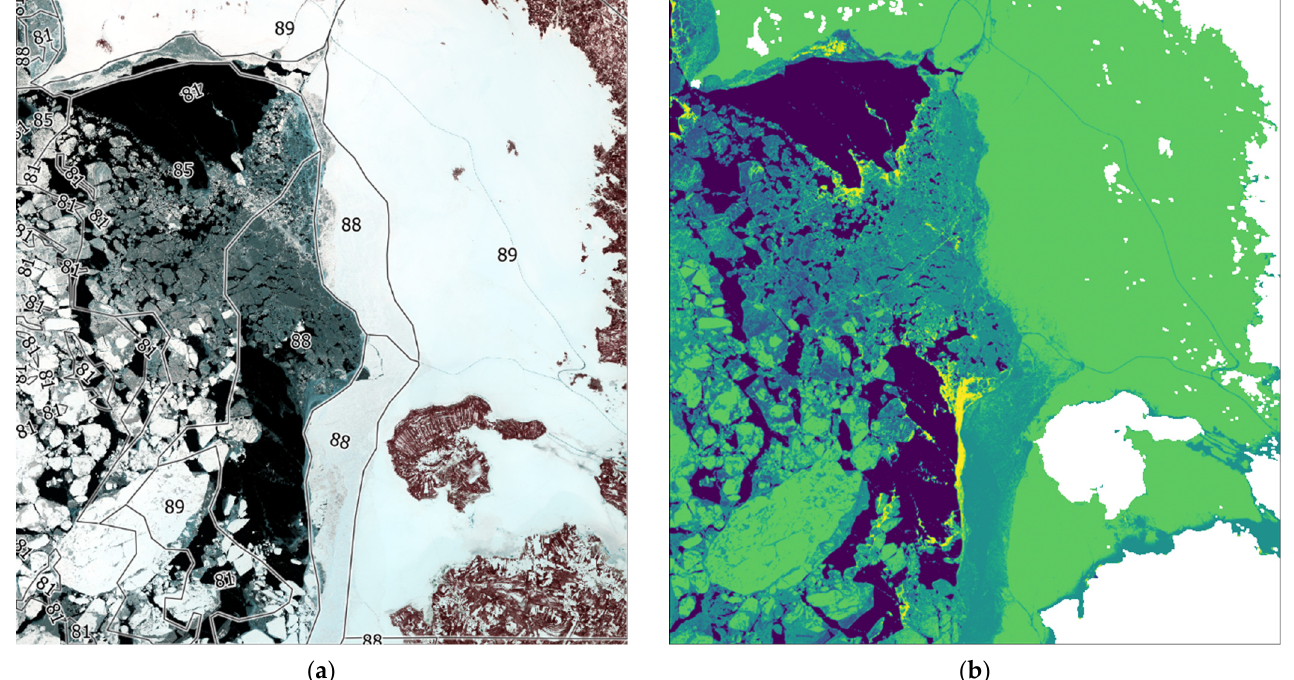
Figure 11. ( a ) Landsat-8 false color for 22 March 2019; BSH ice chart for 21 March 2019; ( b ) ICESOD classification.